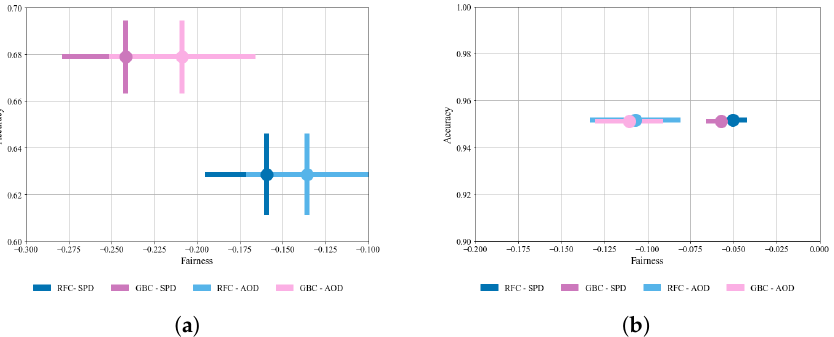
Figure 3. Stability of fairness and accuracy for RFC and GBC. Performance was evaluated using stratified 10-fold CV. For SPD and AOD, values closer to zero indicate more fairness. ( a ) COMPAS; ( b ) LAW.